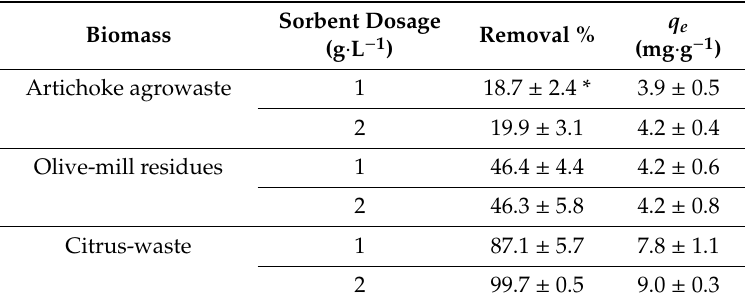
Table 2. Elimination of diclofenac for di ff erent biomass samples.